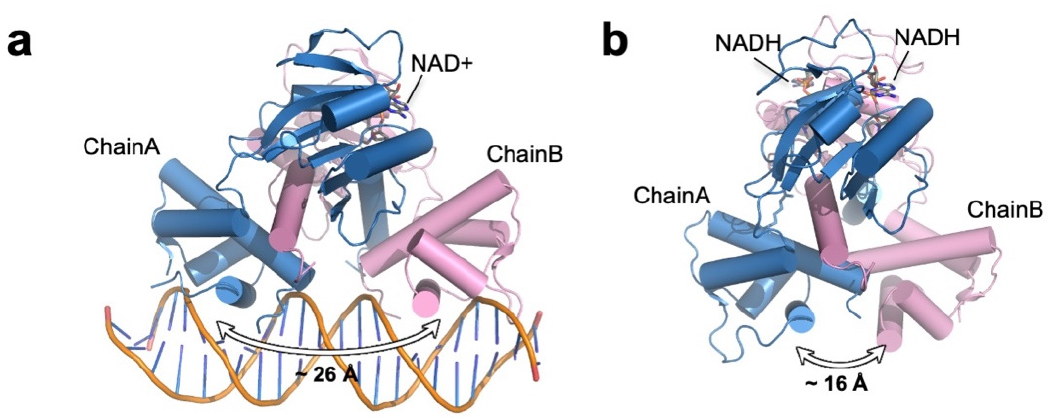
Figure 8. Structural comparison between Rex in complex with ( a ) NAD+ (left, the T. thermophilus Rex–NAD+–DNA complex; PDB ID: 3IKT) and ( b ) NADH (right, the T. aquaticus Rex–NADH complex; PDB ID: 1XCB). The distance denotes the distance between the two HTH motifs in the Rex homodimer (measured as the distance between Lys47/Lys47 ′ C α atoms).